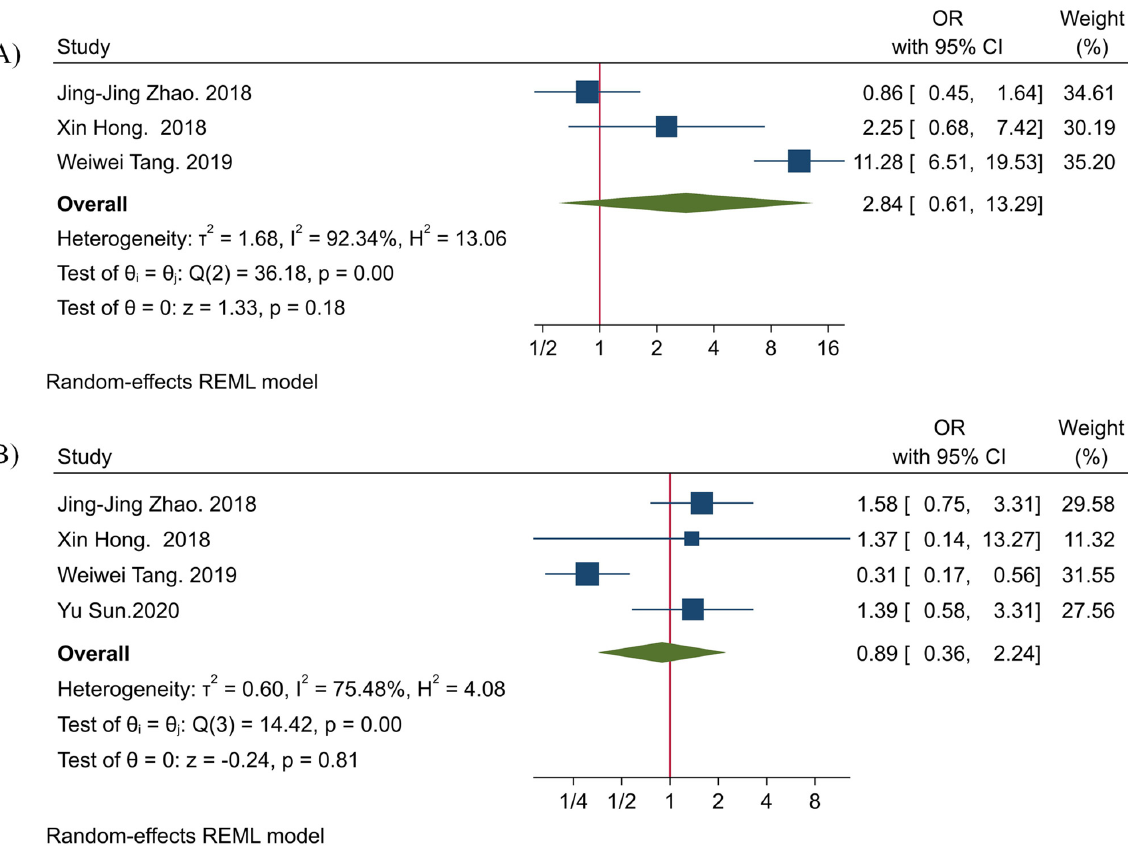
Figure 2. Forest plots for evaluating the association between TIGIT expression and clinicopathological characteristics of affected patients. ( A ) tumor size, and ( B ) tumor differentiation.